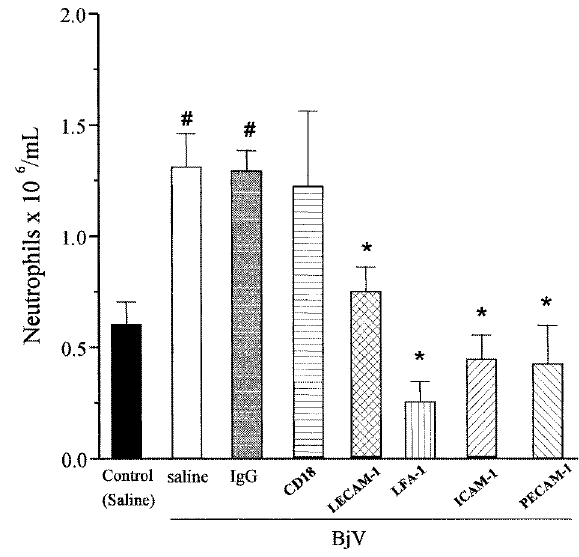
FIG. 1. The effect of anti-murine adhesion molecules on themAbs on the recruitment of peritoneal neutrophils after administration of BjV. Mice were pre-treated i.v. with 1mg/kg of the indicatedmAb, rat normal IgG or saline 30min before i.p. injection of BjV (250 m g/kg). Peritoneal cells were har- vested and counted 6h after envenomation. A negative control group of animals received an i.v. injection of saline. Data represent the mean ± SEM of at least four mice in each group. # p < 0.05 compared with control (saline), * p < 0.05 compared with BjV or BjV + normal rat